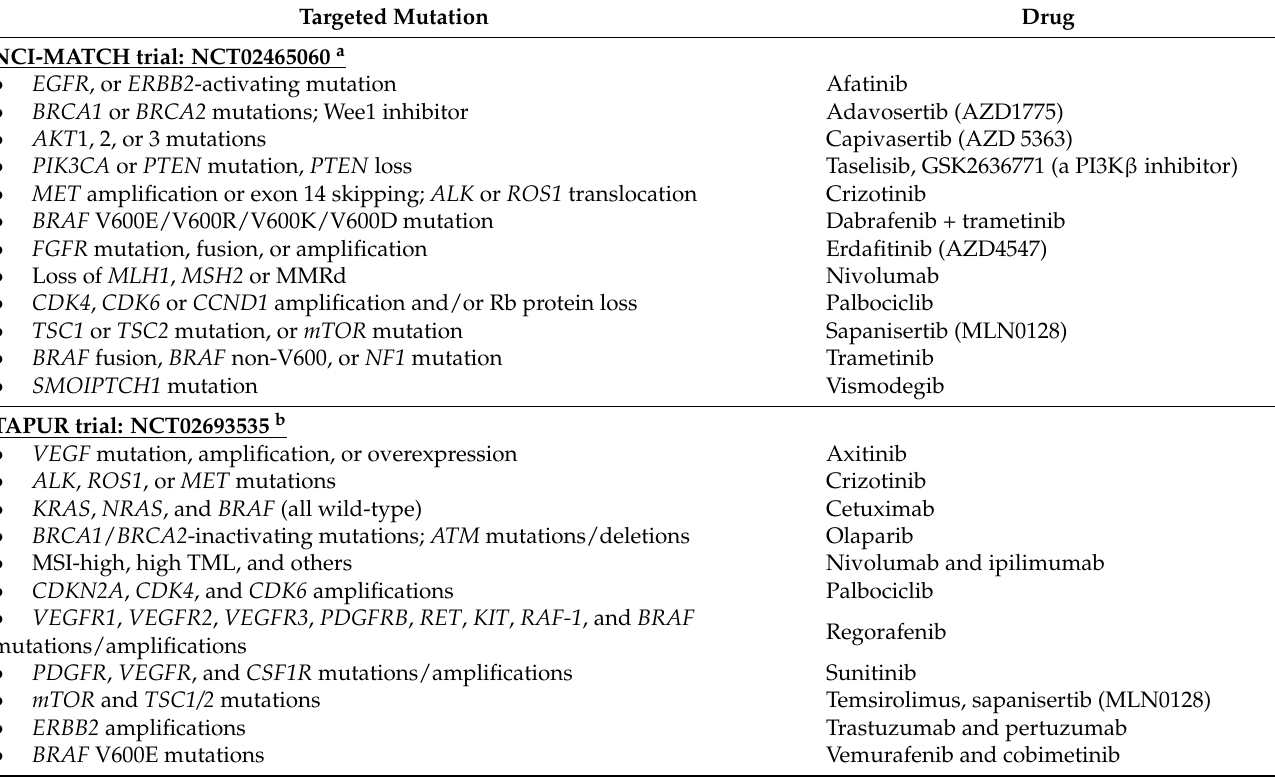
Table 4. Molecular profiling boundaries—biomarker-targeted therapy